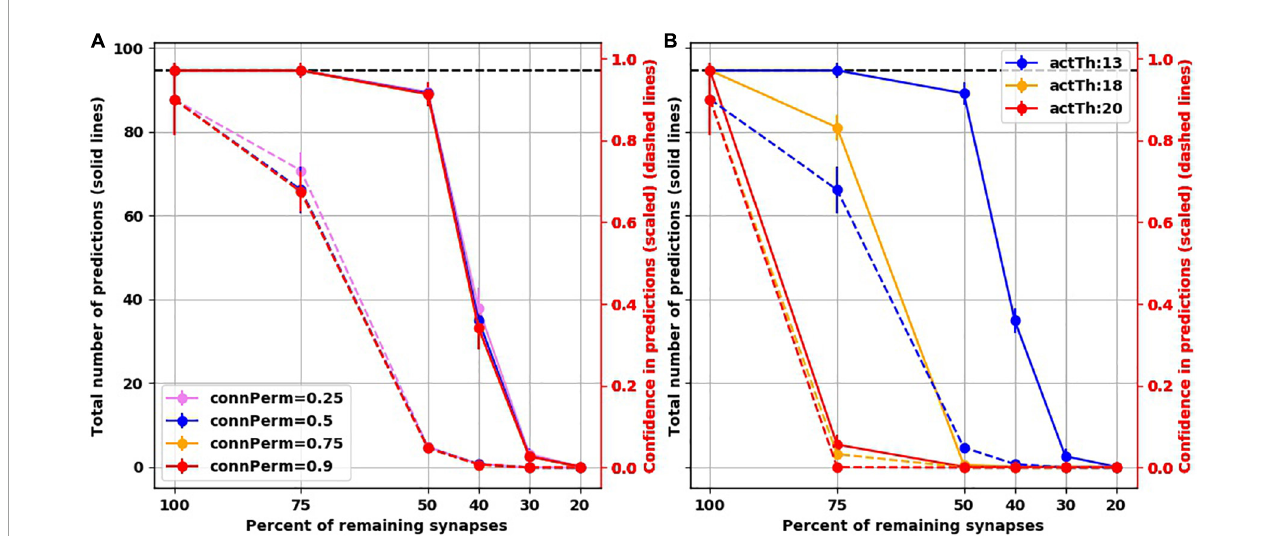
FIGURE6 Examining two hyperparameters of TM. (A) Varying connected permanence did not change the number of predictions the network made with intact synapses or with destruction of synapses (solid lines), or the confidence about these predictions (dashed lines). Circles are mean and error bars are standard deviation across 25 simulations for the intact network and 125 simulations for networks with destroyed synapses. (B) On the contrary, in comparison to activation threshold of 13 (blue lines), increasing activation threshold reduced the total number of predictions (solid lines) with each iteration of synaptic destruction, and reduced confidence about the predictions (dashed lines). Solid circles: mean; error bars: Standard